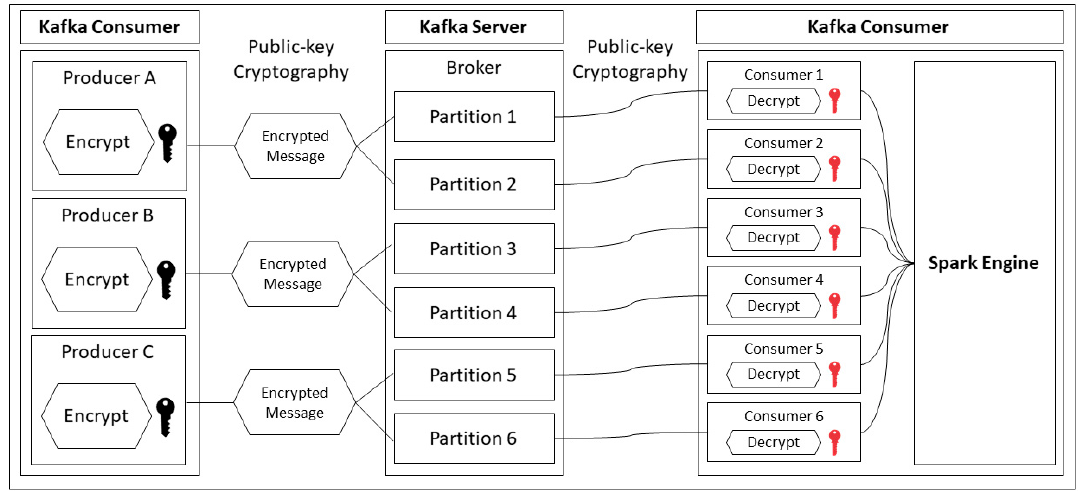
Figure 8. Secured Kafka messages by using public/private key cryptography.